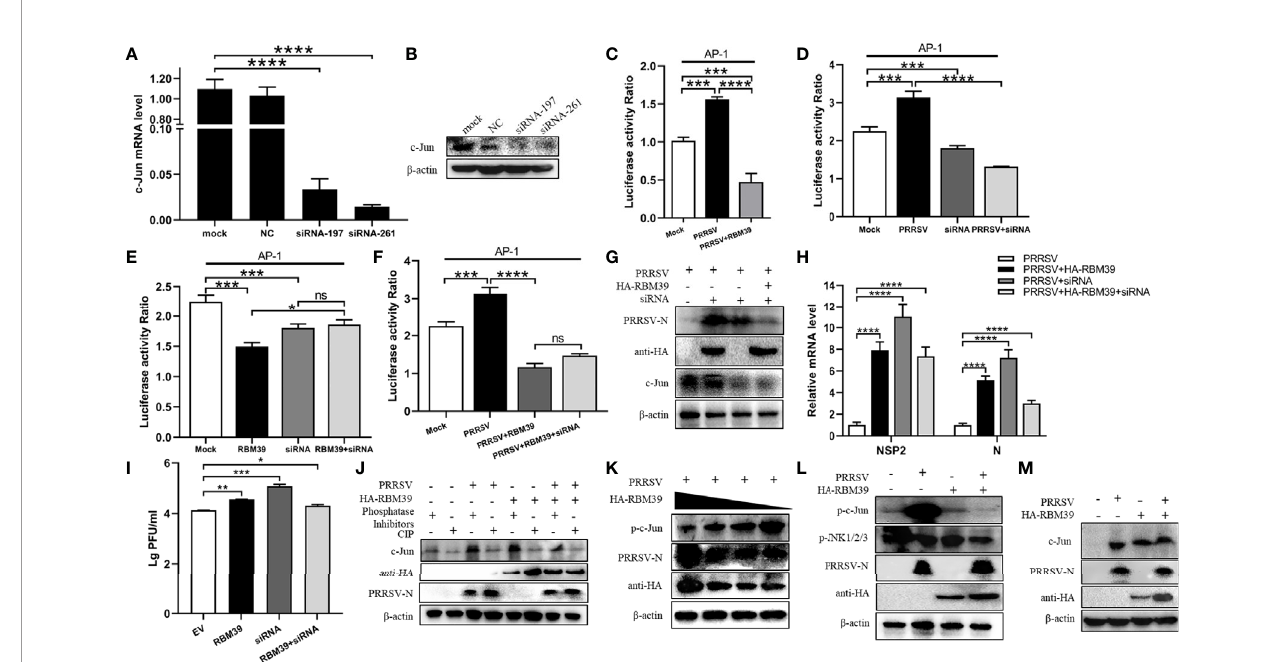
FIGURE 7 | RBM39 affect phosphorylation of c-Jun to down-regulation of AP-1 signaling pathway. 3D4/21 cells were transfected with siRNA of c-Jun or the NC, and the mRNA and protein levels of c-Jun were examined by qRT-PCR (A) and WB analysis (B). (C – F) HEK 293T cells were transfected or co-transfected with RBM39, siRNA of c-Jun, PRRSV infectious clone plasmid, AP-1/Renilla luciferase reporter plasmids. At 24 h after transfection, the luciferase activity of AP-1 promoter reporter gene was measured through Dual Luciferase Reporter Gene Assay Kit (Yeasen Technology). (H, J) 3D4/21 cells were transfected or co- transfected with RBM39 and siRNA of c-Jun, respectively. The cells were infected with o.4 MOI PRRSV 12 h post-transfection and collected another 24 h post- infection. The protein levels of PRRSV N were detected by WB (G) and the mRNA levels of PRRSV N and nsp2 were tested by qRT-PCR (H) . (I) Detection of viral titers of PRRSV in cell supernatants of (H) each experiment group samples. (J) The c-Jun protein level was detected in the condition of phosphatase Inhibitors/CIP treated by WB analysis. (K) 3D4/21 cells were transfected with different concentrations of RBM39 (2µg, 1µg, 1.5µg, 0.5µg). The cell lysates were incubated with Rabbit anti-phospho-c-Jun (Ser73) mAb and detected by Western blotting. (L, M) 3D4/21 cells were transfected or untransfected with RBM39. 12 h after transfection, cells were infected or no infected with PRRSV. The protein levels of p-c-Jun, p-JNK1/2/3 (L) and c-Jun (M) were analyzed by immunoblotting. Data are representative of results from three independent experiments. The statistically signi fi cant at P-value was demonstrated in Statistical Analysis . ns, no signi fi cant